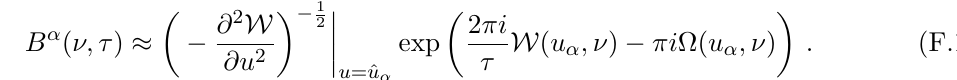
Figure 2 . On the left, the contour (cid:0) (cid:11) is shown for (cid:12)nite (cid:28) , with towers of poles separated by (cid:28) . As (cid:28) becomes small, the contributions from ^ u and its images are dominant, shown in red. On the right, we take the (cid:28) ! 0 limit, where we may approximate the answer by the contribution from u = ^ u . Here the towers of poles have collapsed to form the branch cuts of W ( u ). as in (F.11). The saddle-point approximation at the saddle u = ^ u limit. The (cid:28) (cid:0) 1 = 2 prefactor in (F.14) cancels, leaving us